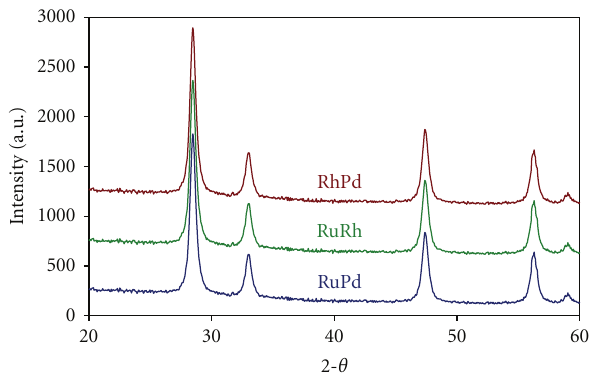
Figure 10: Comparative XRD patterns of the postreformed bimetallic catalysts.